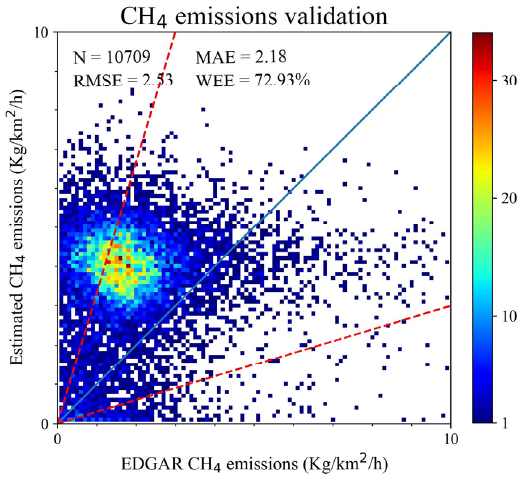
Figure 1. Scatter plots between EDGAR emissions higher than 0.0 kg/km 2 /h and estimated CH 4 emissions. The red line defines an expected error, which characterizes the estimated CH 4 emissions as being three times larger than the EDGAR emissions under certain uncertain